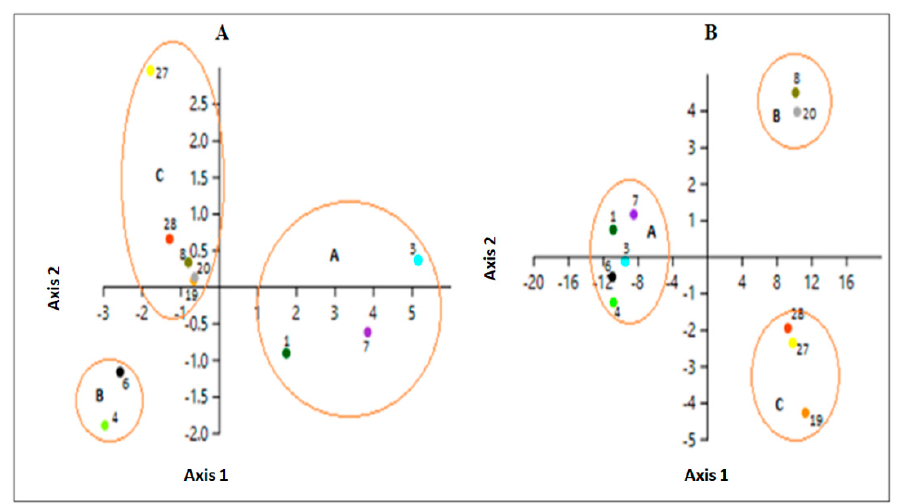
Figure 5. Graphs of the discriminant analysis using morphological ( A ) and molecular data ( B ). In both graphs, the P. coccineus lines were grouped into three groups (A, B and C). The lines are identified with their respective numbers.